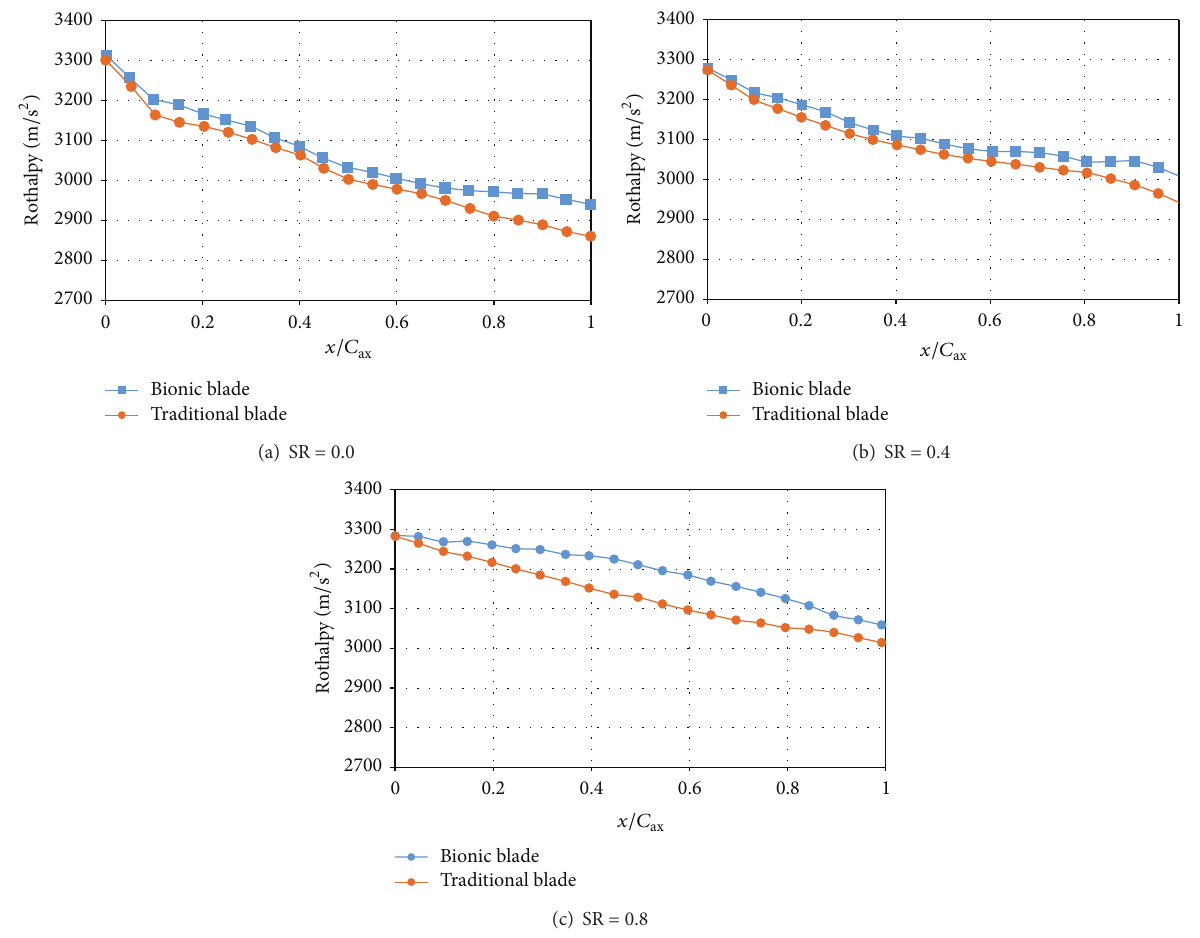
Figure 14: Rothalpy distribution of the pump from inlet to outlet under three conditions.